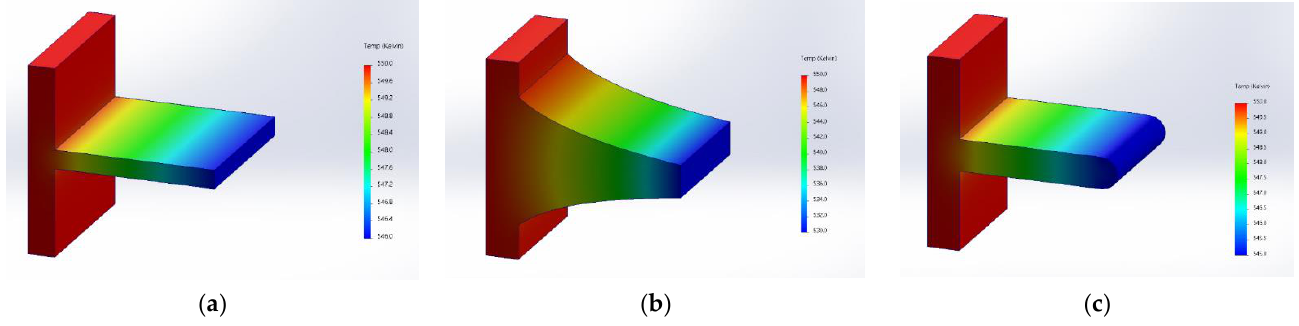
Figure 9. Temperature distribution of ( a ) rectangular; ( b ) exponential; ( c ) convex profile for aluminum alloy (AA6061).